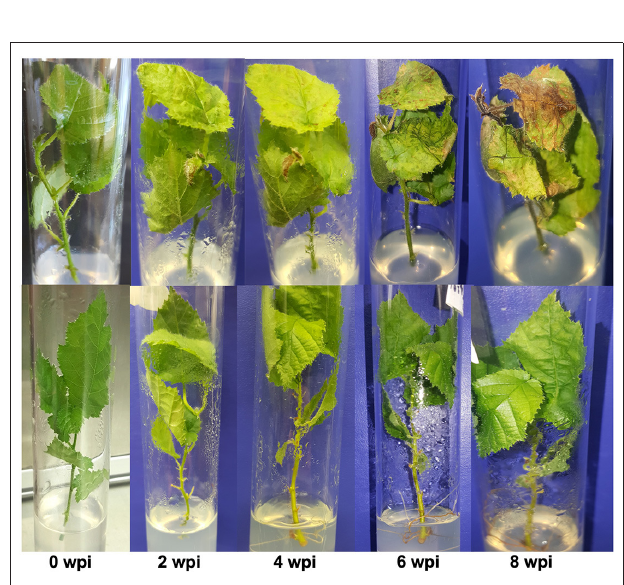
FIGURE 2 | Symptom progression on known bacterial blight susceptible legacy cultivar “Barcelona” following in vitro inoculations with Xac-JL2600 (top row) and water control treatment (bottom row). The Xac-JL2600 treatment (top row) shows a gradual progression of disease symptoms starting at 0 wpi (weeks post-inoculation) with the explant free of visible blemishes or symptoms, slight chlorosis and water-soaked lesion formation beginning at 2 wpi and becoming more prominent by 4 wpi. By 6 wpi, the chlorosis and water-soaked lesions were severe and turning necrotic, moving into the stem by 8 wpi. The water control treatment (bottom row) showed relatively few changes in leaf symptoms throughout the evaluation.